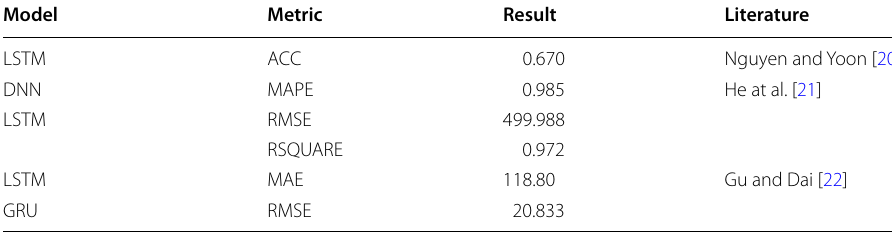
Table 3 Relevant studies using transfer learning method